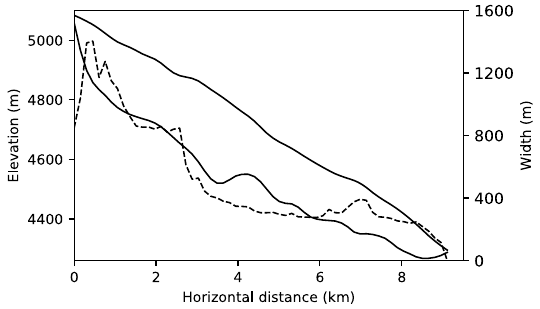
Figure 2. The glacier geometry of LHG12 along the CL. Solid lines show the glacier surface and bed elevations, while the dashed line shows the variation of glacier half widths along the